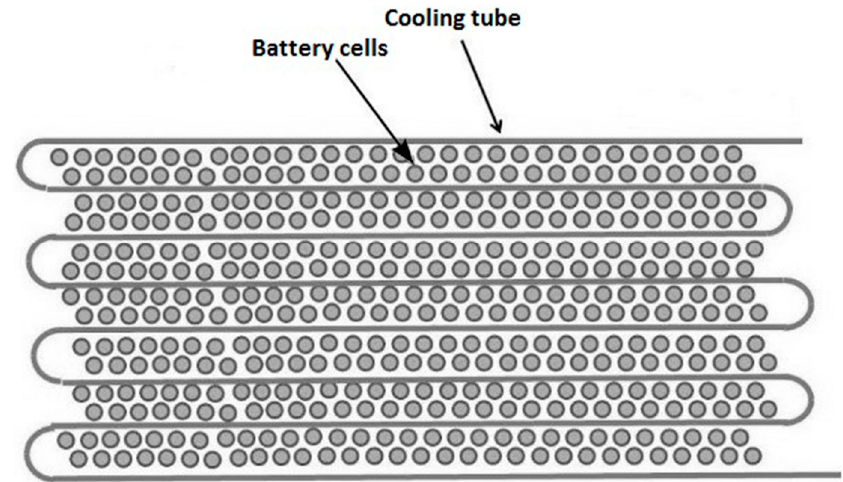
Figure 26. Battery cell arrangement in a battery pack. Cooling tubes are used to dissipate the heat generated in the battery cells.